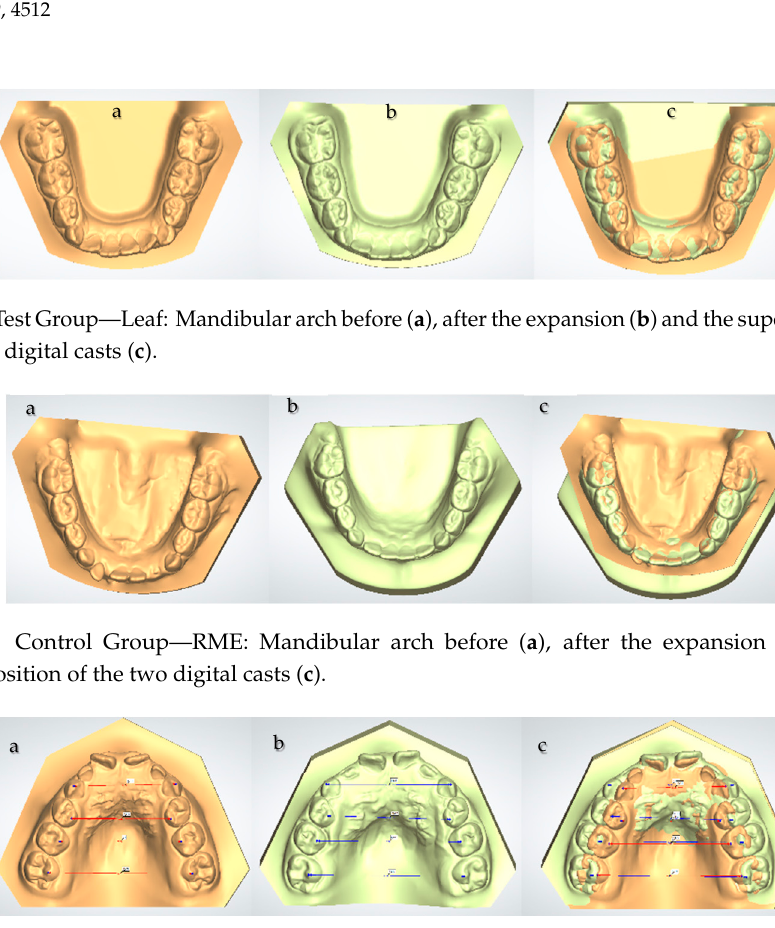
Figure 6. Control Group—RME: Maxillary arch before ( a ), after the expansion ( b ) and the superimposition of the two digital casts ( c ) with the digital landmarks traced by means of 3Shape Ortho Analyzer software.